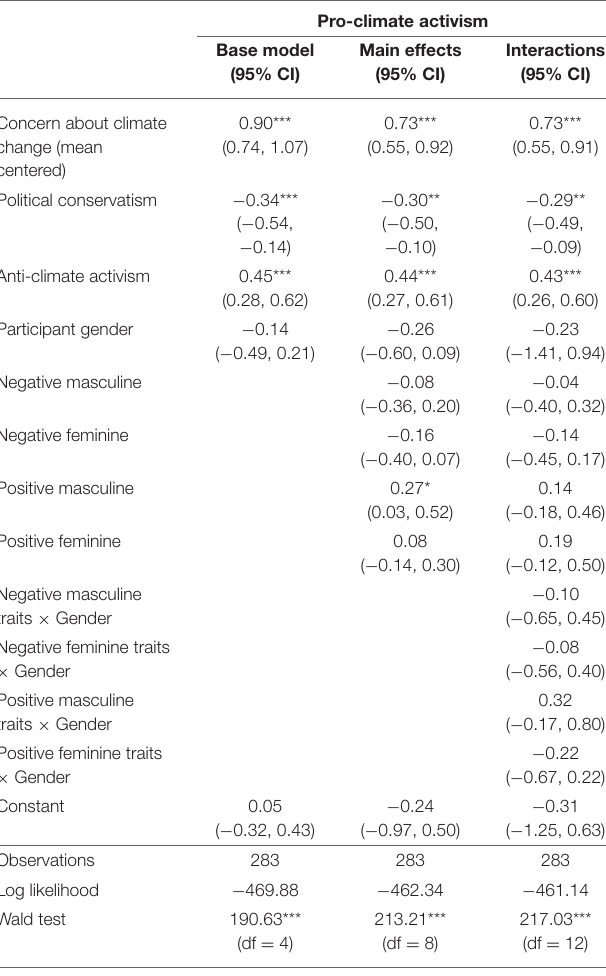
TABLE 2 | Impressions of the climate concerned as predictors of pro-climate activism (Study 1).